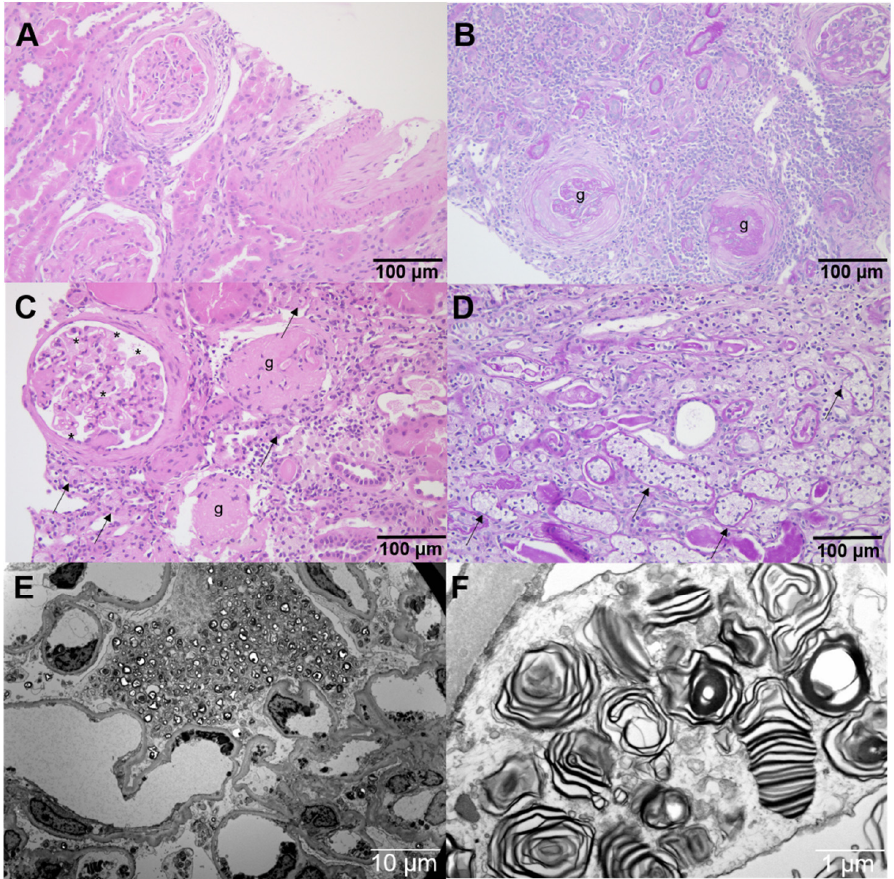
Figure A3. Additional histology and electron microscopy. HE- and PAS-stained paraffin sections from ( A , B ) a non-FD control patient with hypertensive nephropathy, showing arteriosclerosis and chronic parenchymal damage with glomerulosclerosis (g), interstitial fibrosis and tubular atrophy, as well as ( C , D ) from a classical FD patient, showing vacuolated glomerular (*) and tubular (arrows) epithelial cells, in addition to signs of disease progression with global glomerulosclerosis (g). Electron microscopy ( E , F ) from the classical FD patient at ERT-naïve status showing FD-typical electron-dense multilamellar inclusion bodies (zebra bodies), which were pivotal for the